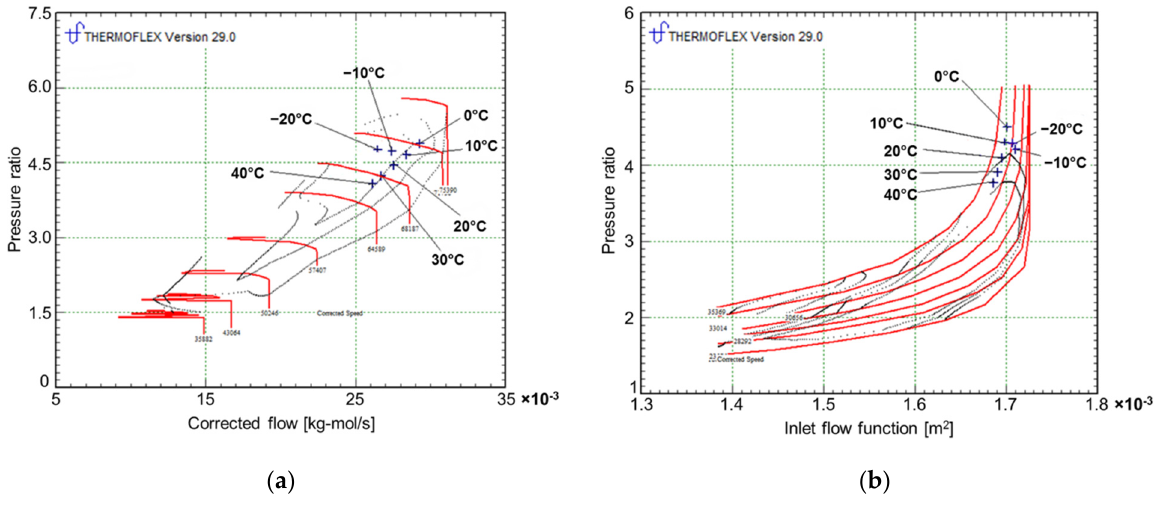
Figure 3. Effects of ambient temperature on performance maps of: ( a ) compressor; ( b ) turbine.